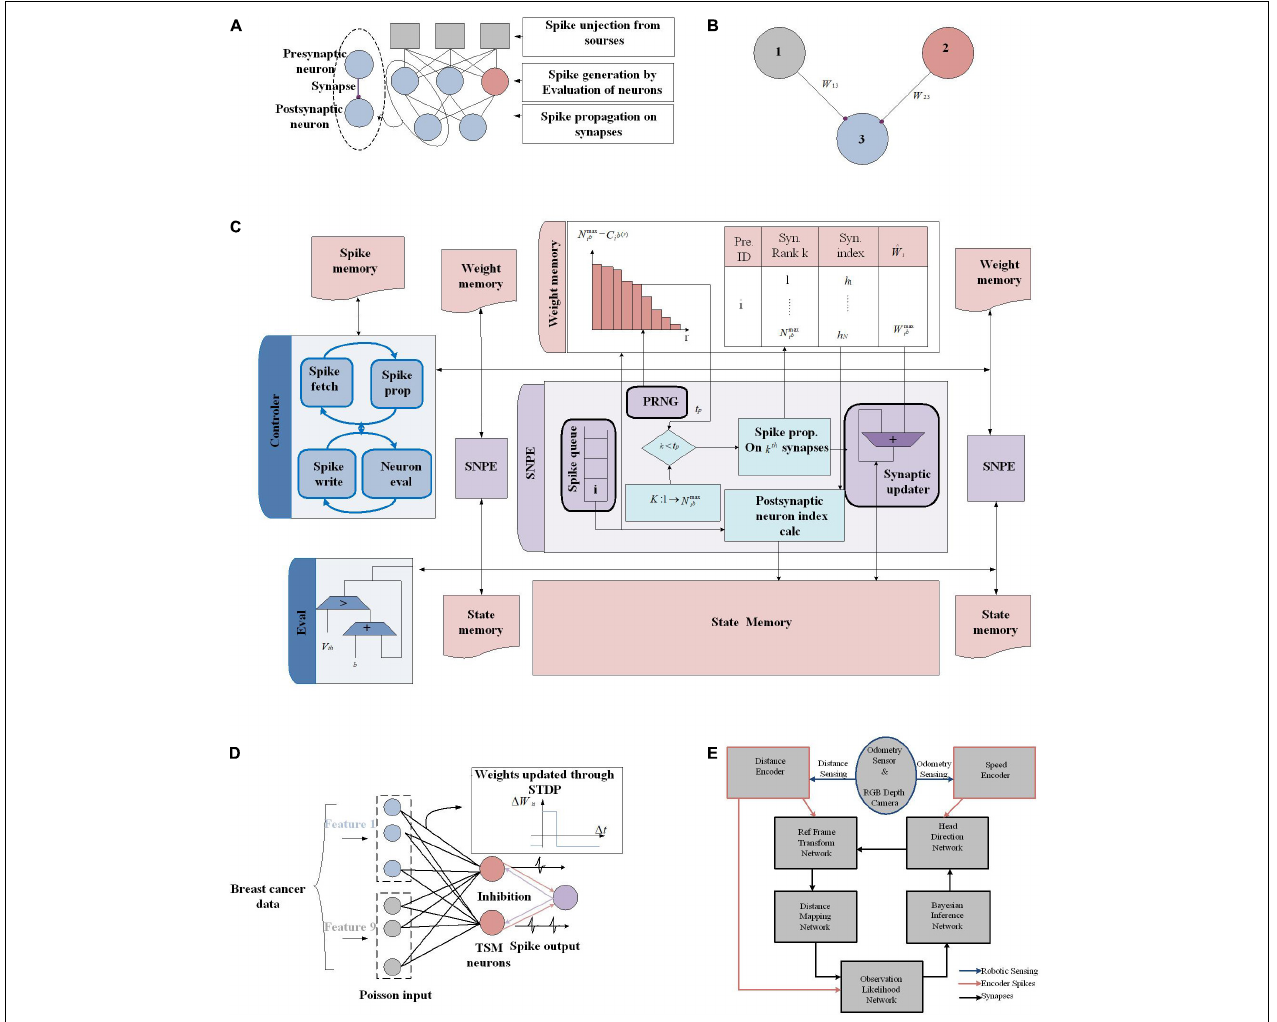
FIGURE 14 | (A) A generic structure of spiking neural networks. (B) Neuron 3 receives spikes from Neuron 1 and Neuron 2. (C) P-SNNAP accelerator architecture in Nallathambi et al. (2021). (D) Stochastic neuron based probabilistic spiking neural network implantation for the uncertainty quantification problem in medical diagnosis (Wang et al., 2021). The probabilistic SNN consists of the input encoding layer, the output layer, and the inhibitory layer. Neurons mimic the biological neurons behavior. Each feature of breast cancer data is encoded by the firing rate of a small population of Poisson neurons. The inset depicts the STDP learning curve of synapses connecting input neurons to the output ones; if the post-spike falls within the time window after the pre-spike, then the synaptic potentiation will occur. (E) Overall structure of the implemented SNN architecture on the Loihi processor (Tang et al.,